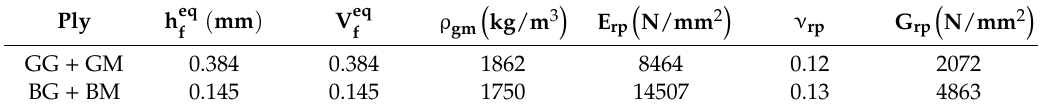
Table 11. Homogenised properties of the grid mortar / plies.